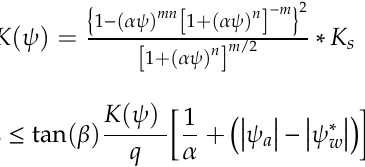
Figure 17. ( a ) Side view of the diversion length and breakthrough area of the capillary barrier (the movement and the breakthrough zone are shown by the blue dye traces); ( b ) calculation of the capillary diversion length L.